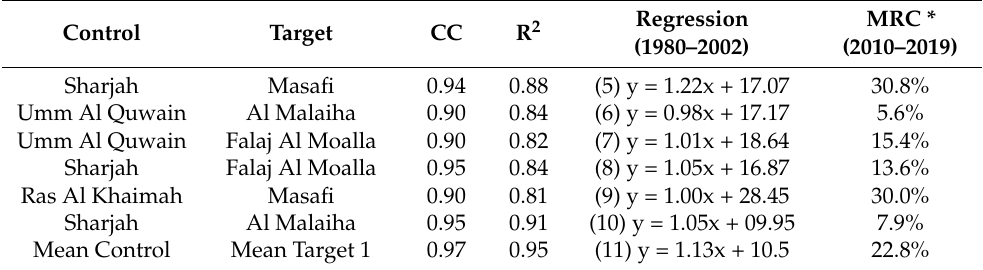
Table 2. Correlation and R 2 coefficient values between pairs of control-target gauges, the correspond- ing regression equations (1980–2002) and the mean relative change (MRC) over the seeding period